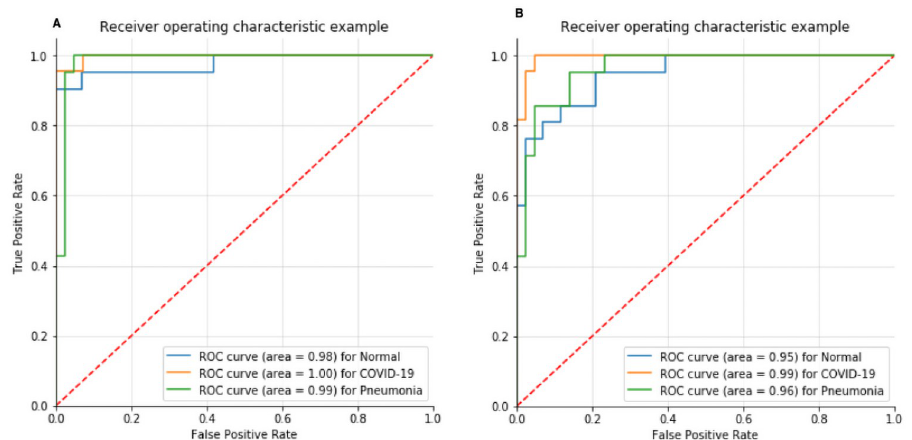
Fig 14. ROC curve in scenario II for (A) build CNN and (B)